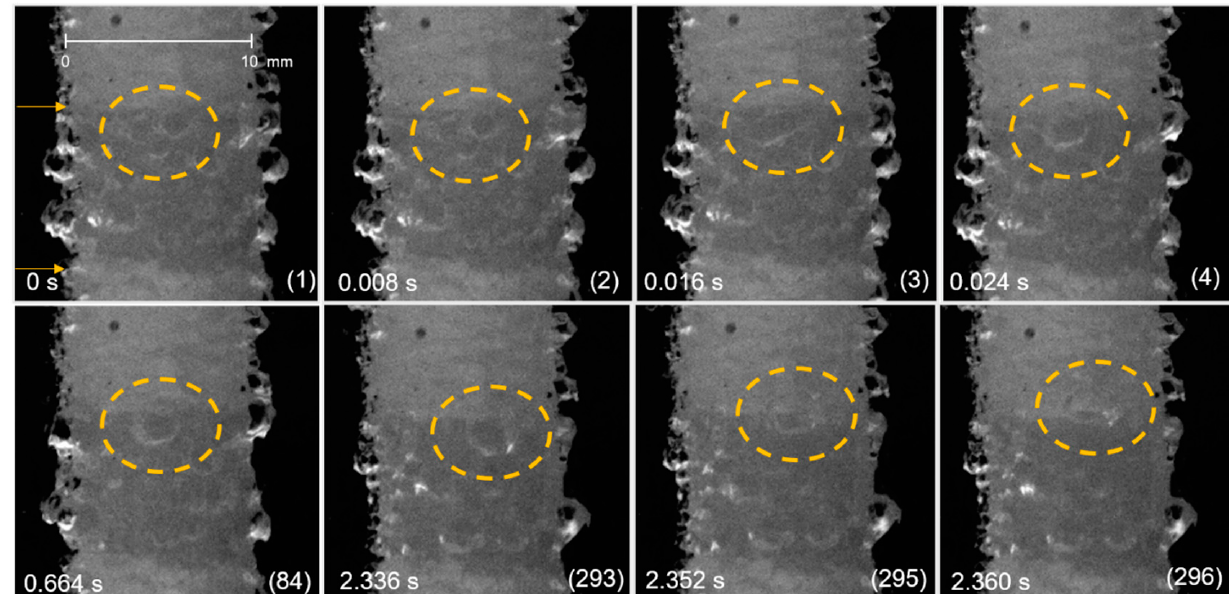
Figure 14. Process of coalescence of three bubbles (marked in yellow dashed line) into one larger bubble and its prolonged resting at the upper part of the anode at the boundary between BN and C during electrolysis at a constant current density of 0.1 A cm − 2 . The frame rate was 125 fps. The frame number is given in the brackets. Frame (1) is defined as 0 s, indicating the start of the coalescence process. A scale bar is shown in frame (1). The yellow arrows in frame (1) indicate the C-BN borders.